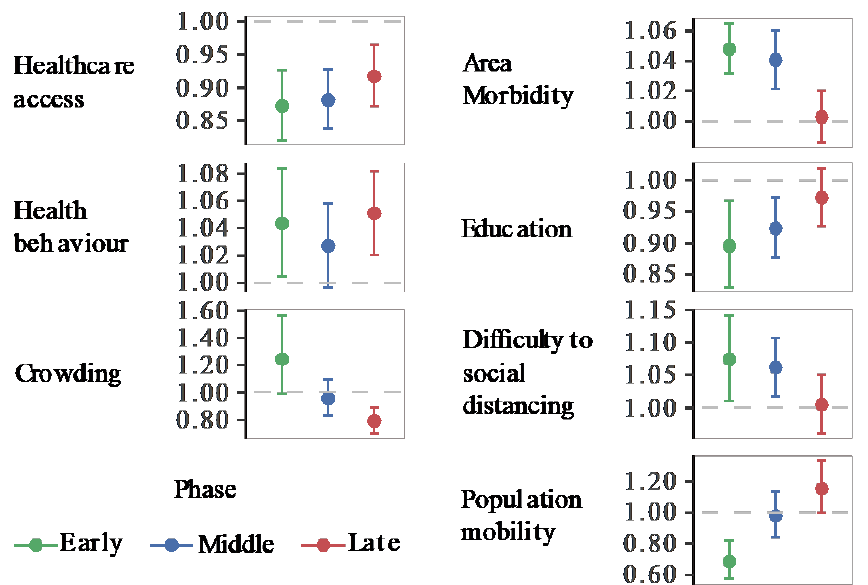
Figure 3. Relative Risk of COVID-19 associated with area health and SES determinants (GNBR models). Each panel shows the relative risk and its 95% confidence intervals associated with each thematic area. Colours represent the pandemic’s early (20 January to 20 March 2020), middle (21 March to 15 April 2020), and late phases (16 April to 1 July 2020). The dashed line shows the reference level (1). Values over or below the reference line indicate statistically significant results at α = 0.05. Corresponding p -values can be found in Table S5.